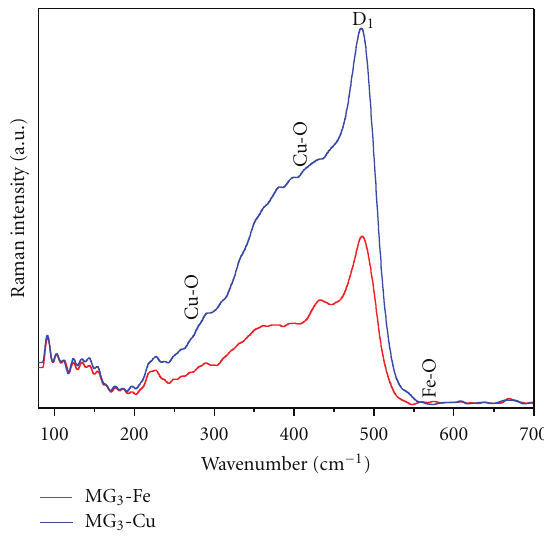
Figure 6: Raman scattering spectra at 80–700 cm − 1 of MG 3 -Cu and MG 3 -Fe doped.